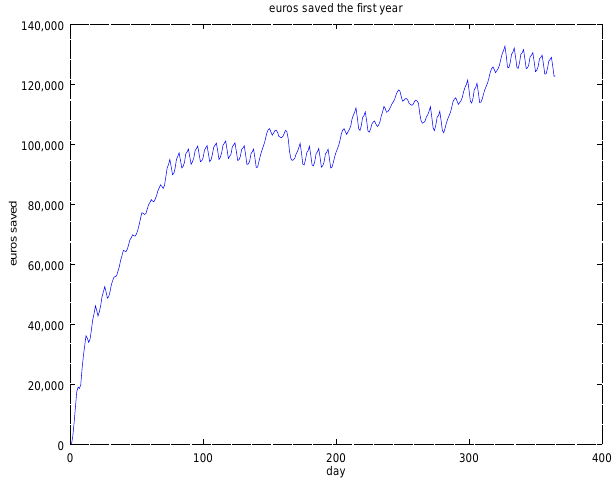
Figure 10. Operation cost saved during the first year.